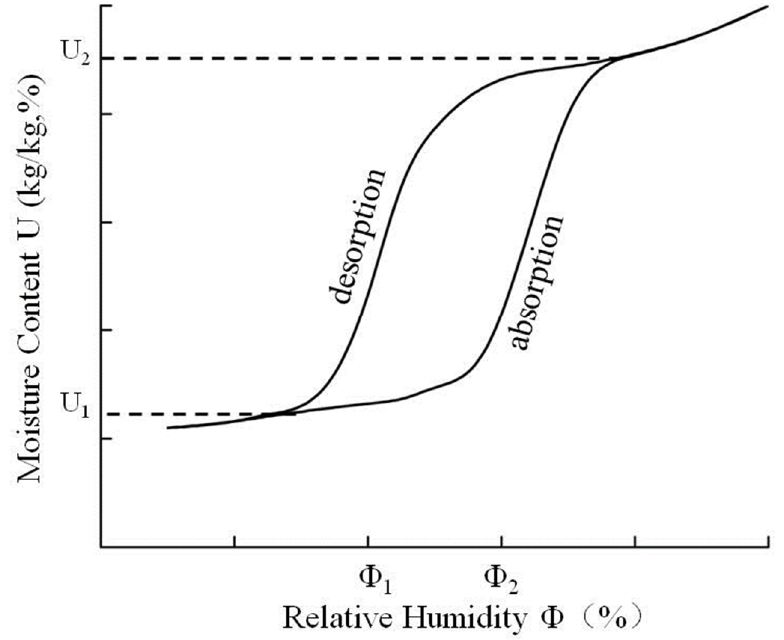
Figure 1. Isothermal desorption and adsorption curve of hygroscopic materials [31].